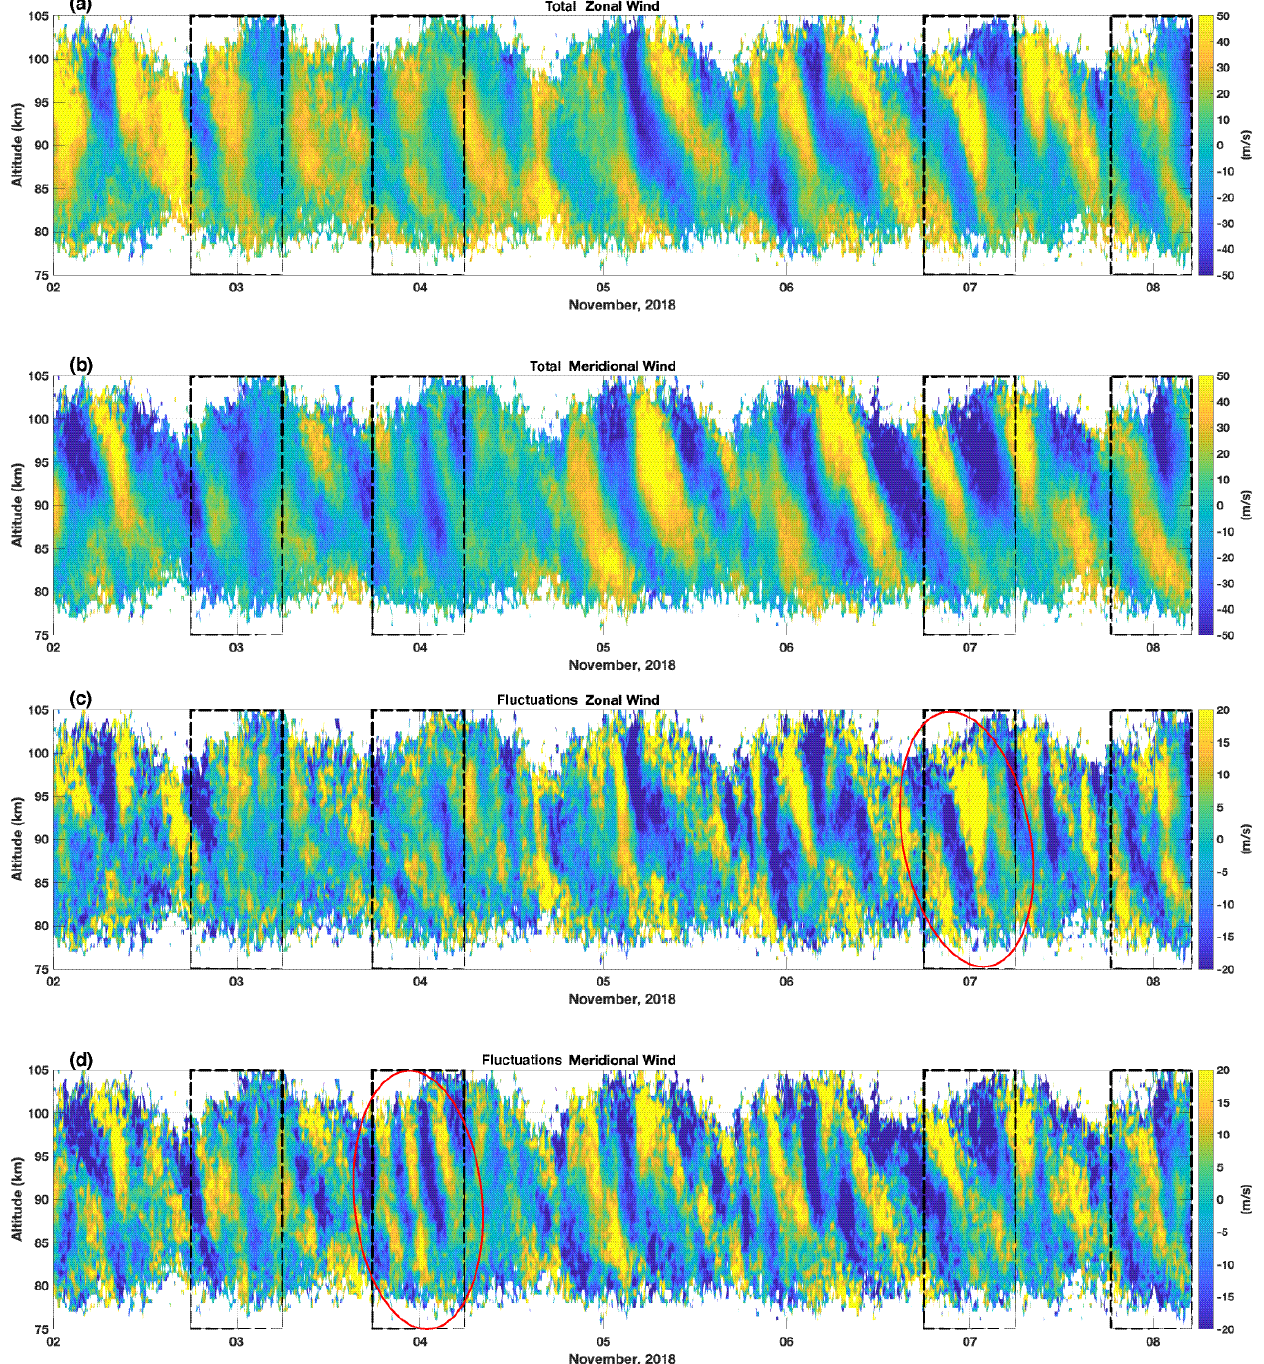
Figure 2. (a) Zonal and (b) meridional wind measurements for the duration of the SIMONe–2018 campaign generated by the MSMR network. Note the dominance of the semidiurnal tide on the horizontal wind. (c) Zonal and (d) meridional wind fluctuations of τ o ≤ 4h. Note the presence of coherent gravity wave features (red ellipses) on 3–4 November in the meridional wind fluctuations and on 6–7 November in the zonal wind fluctuations coincident with enhanced keogram brightness for the same nights in Fig. 1. Dashed boxes indicate hours of simultaneous operation of the ASI and MSMR